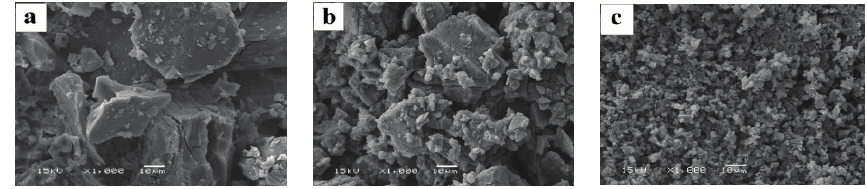
Figure 5. SEM images of β -CD ( a ); the physical mixture ( b ) and the inclusion complex ( c